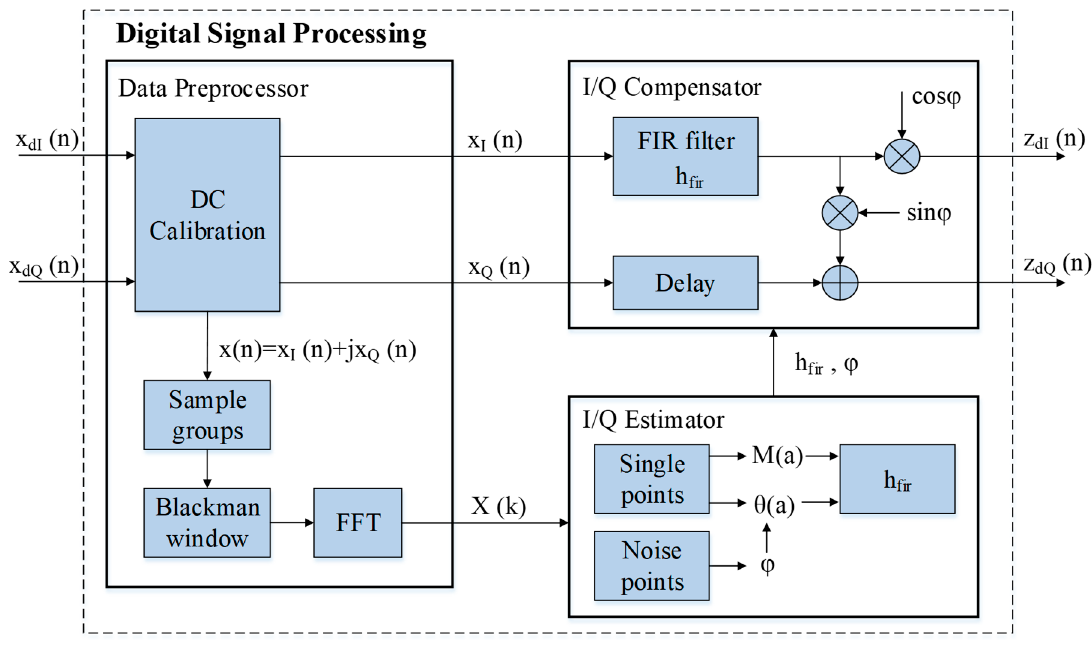
/ Q imbalance calibration Figure 5. I/Q imbalance calibration model. Figure 5. I Figure 5. I/Q imbalance calibration model.